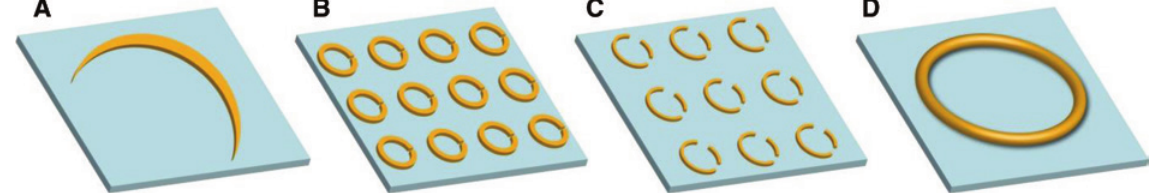
Figure 11: Various ring-shaped